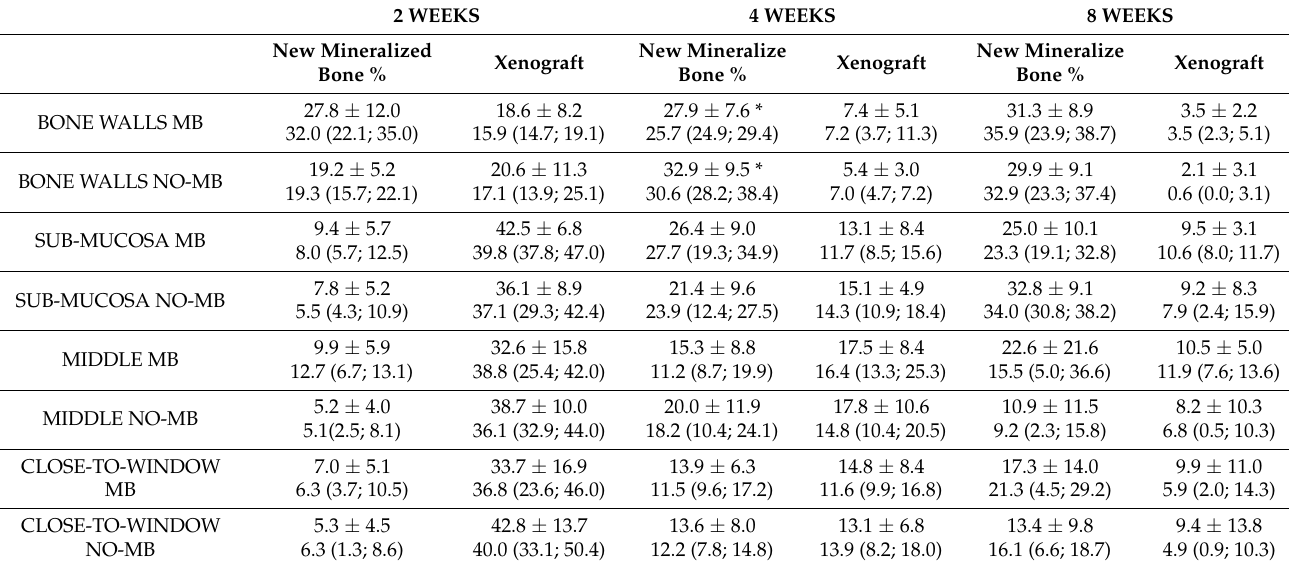
Table 2. Mineralized new bone and xenograft percentages (%) in the various regions evaluated after 2, 4, and 8 weeks of healing. Mean value ± standard deviation on the first line; median (25 and 75 percentiles) on the second line.